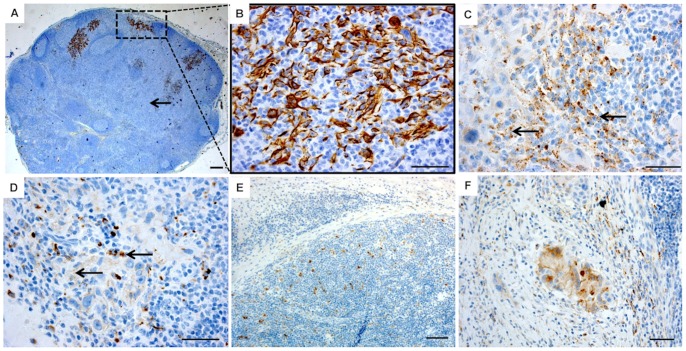
Cathepsin K immunostaining pattern in lymph node metastases of OTSCC is similar to the primary tumor.Metastatic carcinoma cells were identified with pancytokeratin staining (A–B), followed by cathepsin K staining of the paired primary OTSCC (C) and lymph node metastases (D) (n = 10, the paired sections were taken from the same patient). The arrows indicate similar cathepsin K staining patterns in both the primary tumor and in the lymph node metastases. Lymph nodes without metastases contain some cathepsin K positive cells (E), but the stromal reaction drastically changes in the presence of cathepsin K positive OTSCC cells (F). Scale bars 200 µm.